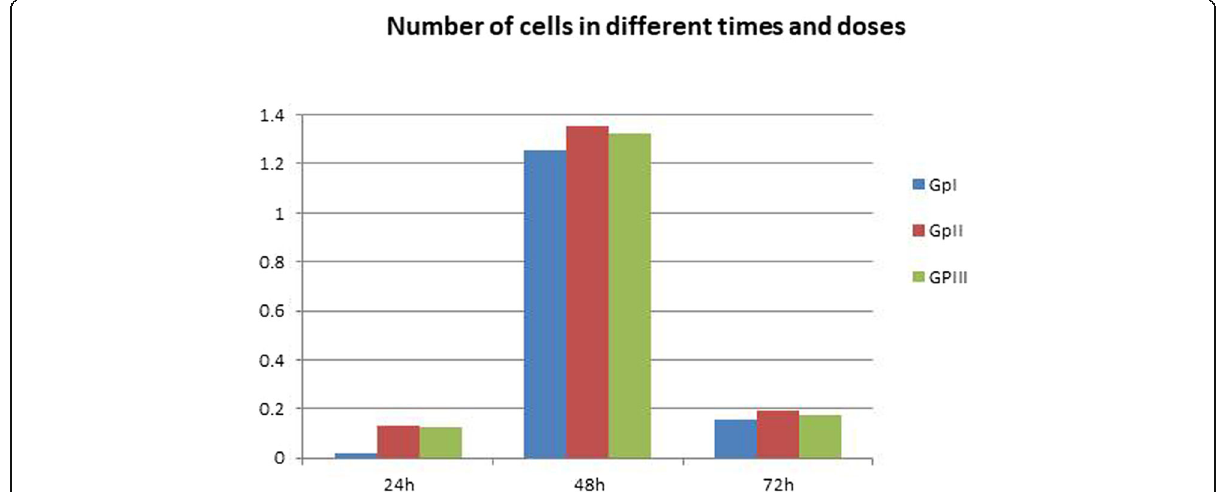
Fig. 4 Histogram illustrating the number of cells in different times and doses